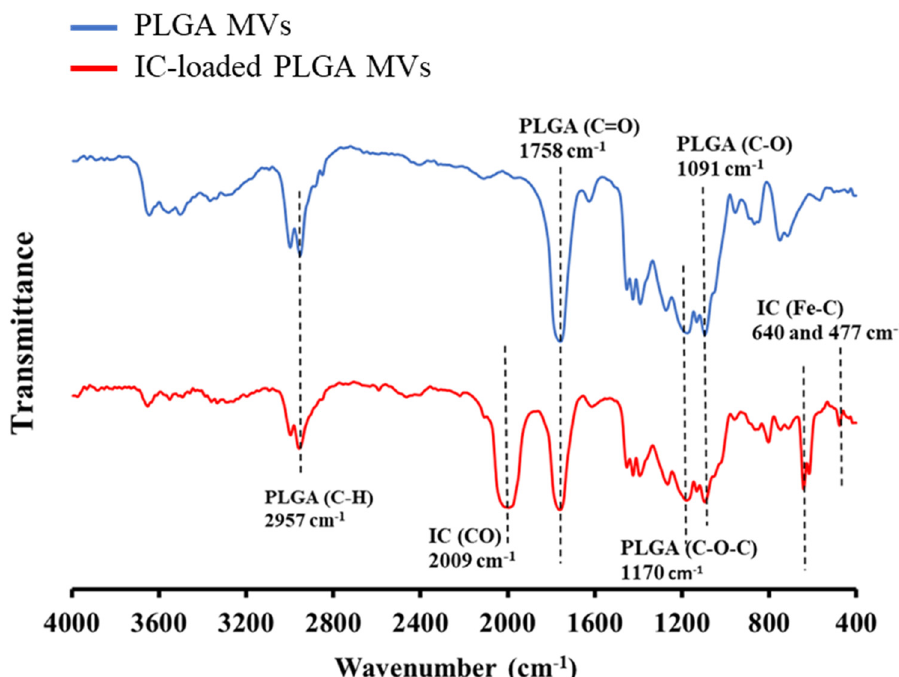
Figure 5. FT ‐ IR analysis of PLGA MVs and IC ‐ loaded PLGA